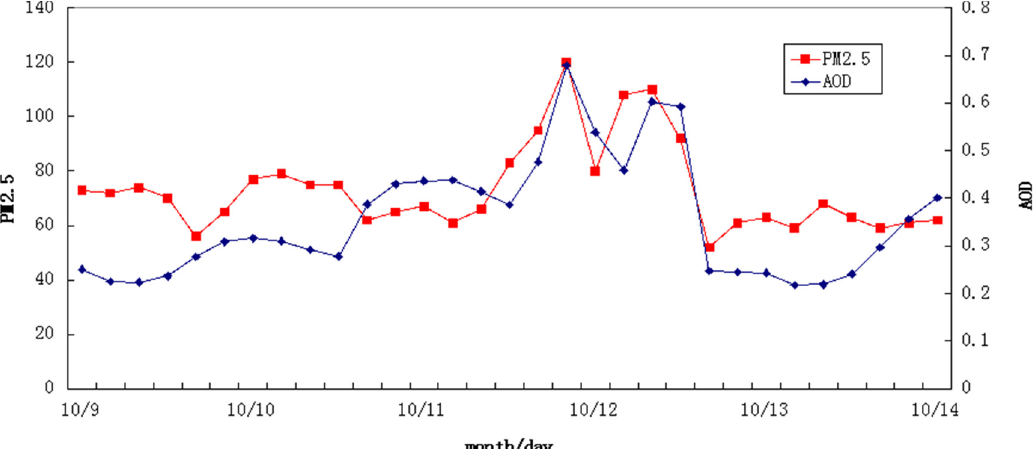
Figure 6. Variation in aerosol optical depth (AOD) and concentration of particles with a diameter below 2.5 µm (PM 2.5 ) on 9–14 October 2014. The red line shows the change trend of PM 2.5 . The blue line shows the change trend of AOD.